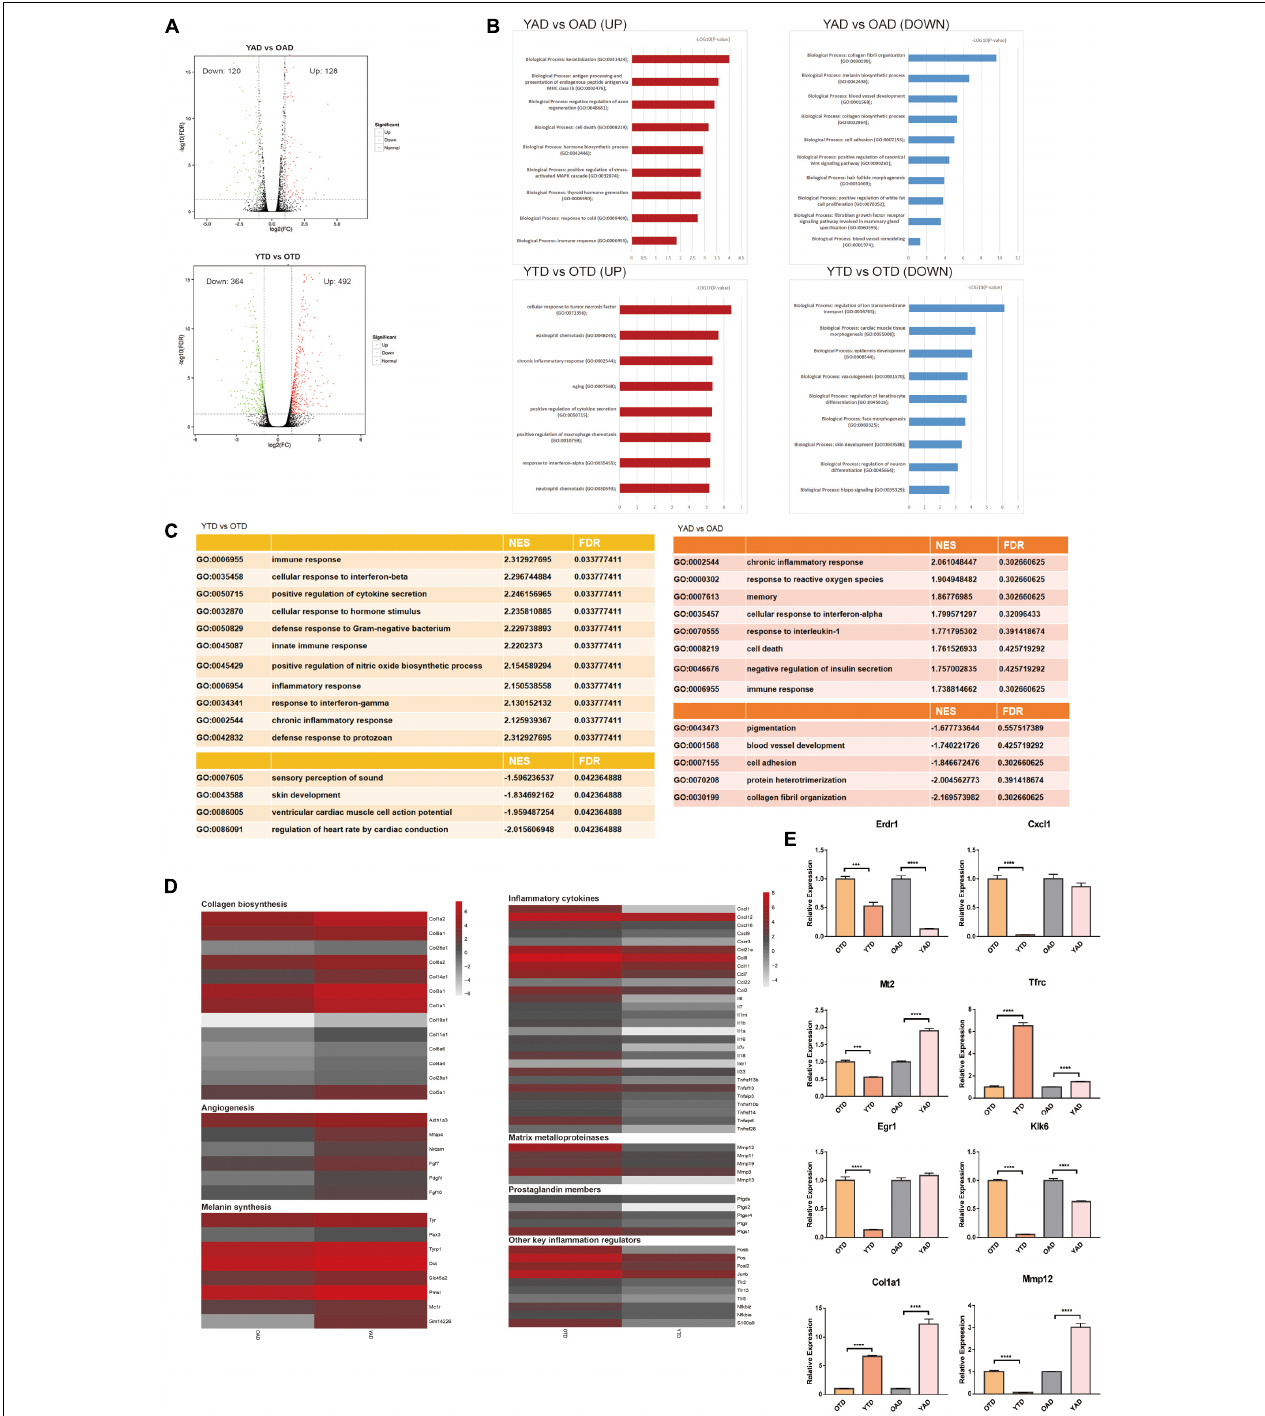
FIGURE 2 | Overview of dWAT alterations with aging at anagen and telogen. (A) Volcano Plots of DEGs in YTD vs OTD and YAD vs OAD. (B) GO enrichment analysis respectively for upregulated and downregulated DEGs in YTD vs OTD and YAD vs OAD. (C) GSEA analysis indicated the most significantly enriched terms in YTD vs OTD and YAD vs OAD. However, in YAD vs OAD, all terms’ FDR exceeds 0.05, which only represents general trends. (D) Heat map of genes related to collagen biosynthesis, angiogenesis, and melanin synthesis with significant changes in YAD vs OAD, and inflammation-related genes with significant changes in YTD vs OTD. Genes expressed at low levels are in gray, and genes expressed at high levels are in red. (E) qRT-PCR validation of selected significant DEGs (Klk6 and Erdr1are significant UP_DEGs and Col1a1and Mt2 are significant DOWN_DEGs in YAD vs OAD; Cxcl1, Egr1, Mmp12 are significant UP_DEGs and Tfrc is significant DOWN_DEG in YTD vs OTD). For each experimental data point, n = 8. *** P < 0.001, and **** P < 0.0001.